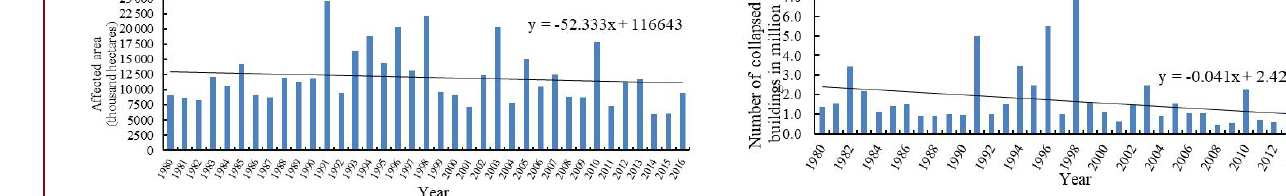
Figure 1. Data of flood-affected area from 1980–2016 (MWR, 2007–2016).